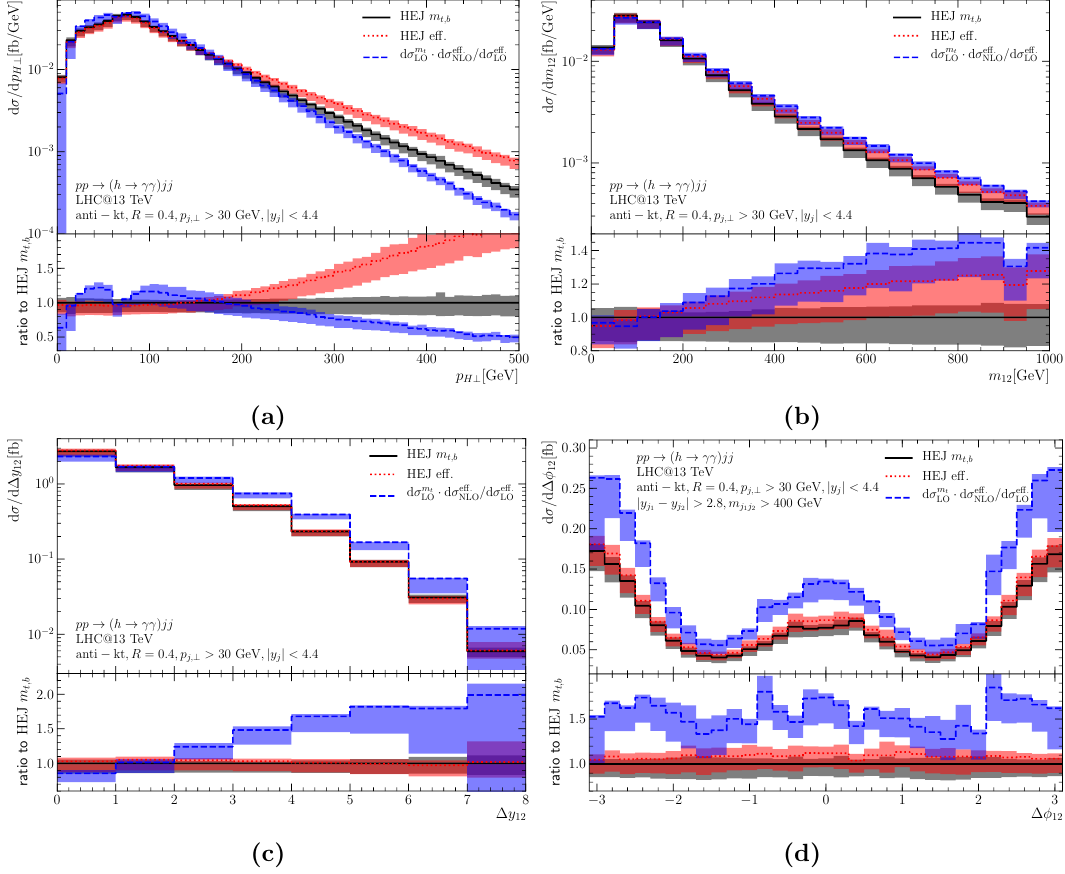
Figure 15 . Comparison between HEJ and the rescaled leading-order prediction for various distri- butions with the central scale choice (cid:22) r = (cid:22) f = H T = 2. See (cid:12)gure 11 for the corresponding plots with (cid:22) r = (cid:22) f = max( m H ; m 12